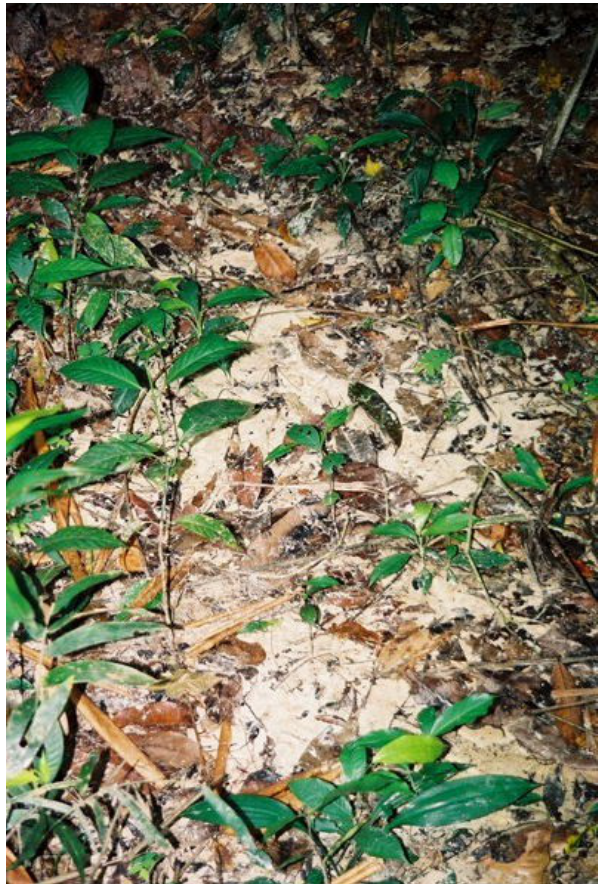
Figure 7. Fine white sediment originating from upstream gold mining is deposited in the riparian forest along Mamanari Creek, Suriname, after inundation of the floodplain forest during a high-flow event. See Mol and Ouboter [34] for details. © Jan H. Mol (capture date of photograph 12 April